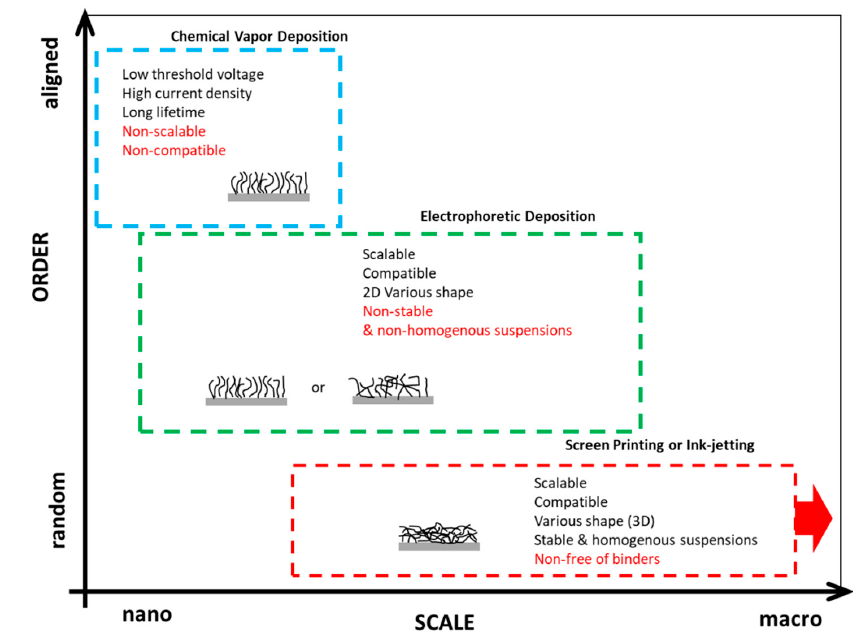
Figure 6. The graph presenting the possible scalability (horizontal axis) and the alignment of CNTs (vertical axis) obtained for various techniques to form FE cathodes (the author’s work).